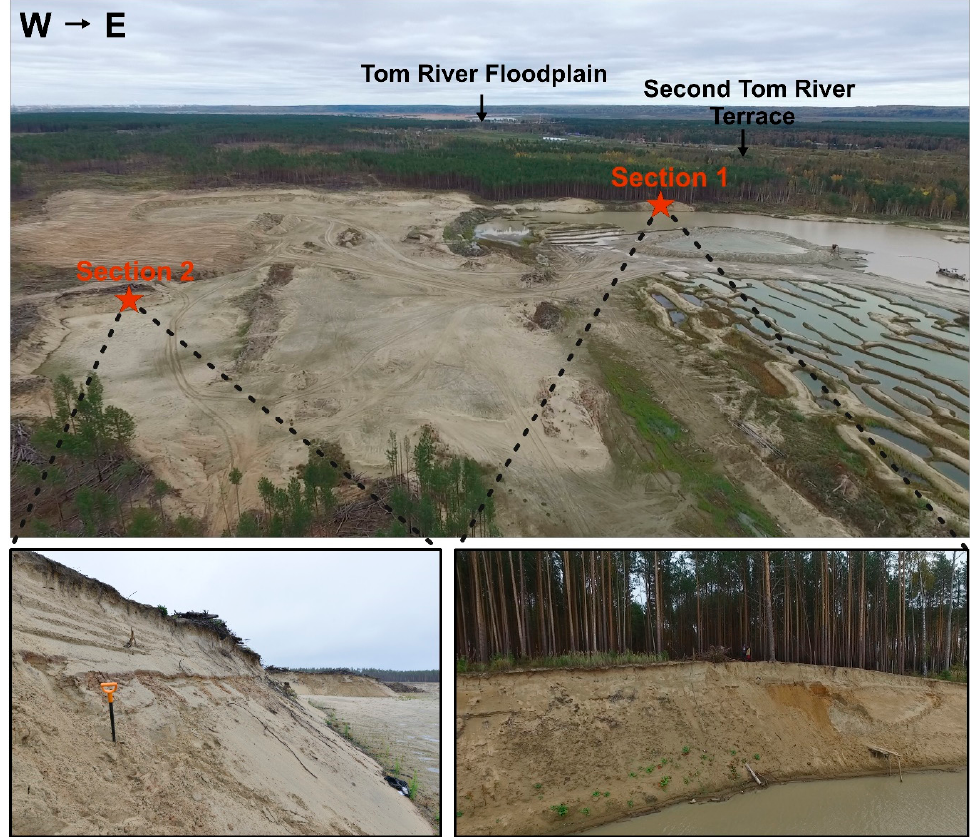
Figure 2. Location of sections with paleosols within the territory of Tachtamishevo quarry (photographs made by drone).